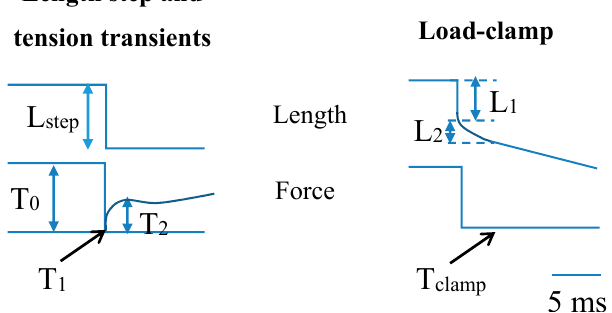
Figure 4. Schematic illustration of length step experiment ( left ) giving rise to tension (force) transients and load-clamp experiment ( right ) giving rise to velocity transients of muscle cells followed by steady-state shortening at constant velocity. In the length-step experiment length is controlled and the resulting tension transient includes a drop of tension from the isometric value, T 0 down to the extreme tension level at the end of the length step, T 1 . This is followed by a subsequent rapid recovery to the intermediate tension level T 2 (see further text). In the load-clamp experiment, load (force) is controlled, and the resulting length changes are recorded, e.g., the initial elastic response (amplitude L 1 ) when force drops and the subsequent rapid phase of shortening (phase 2; ending at length L 2 ) before slower shortening at a steady-state rate.